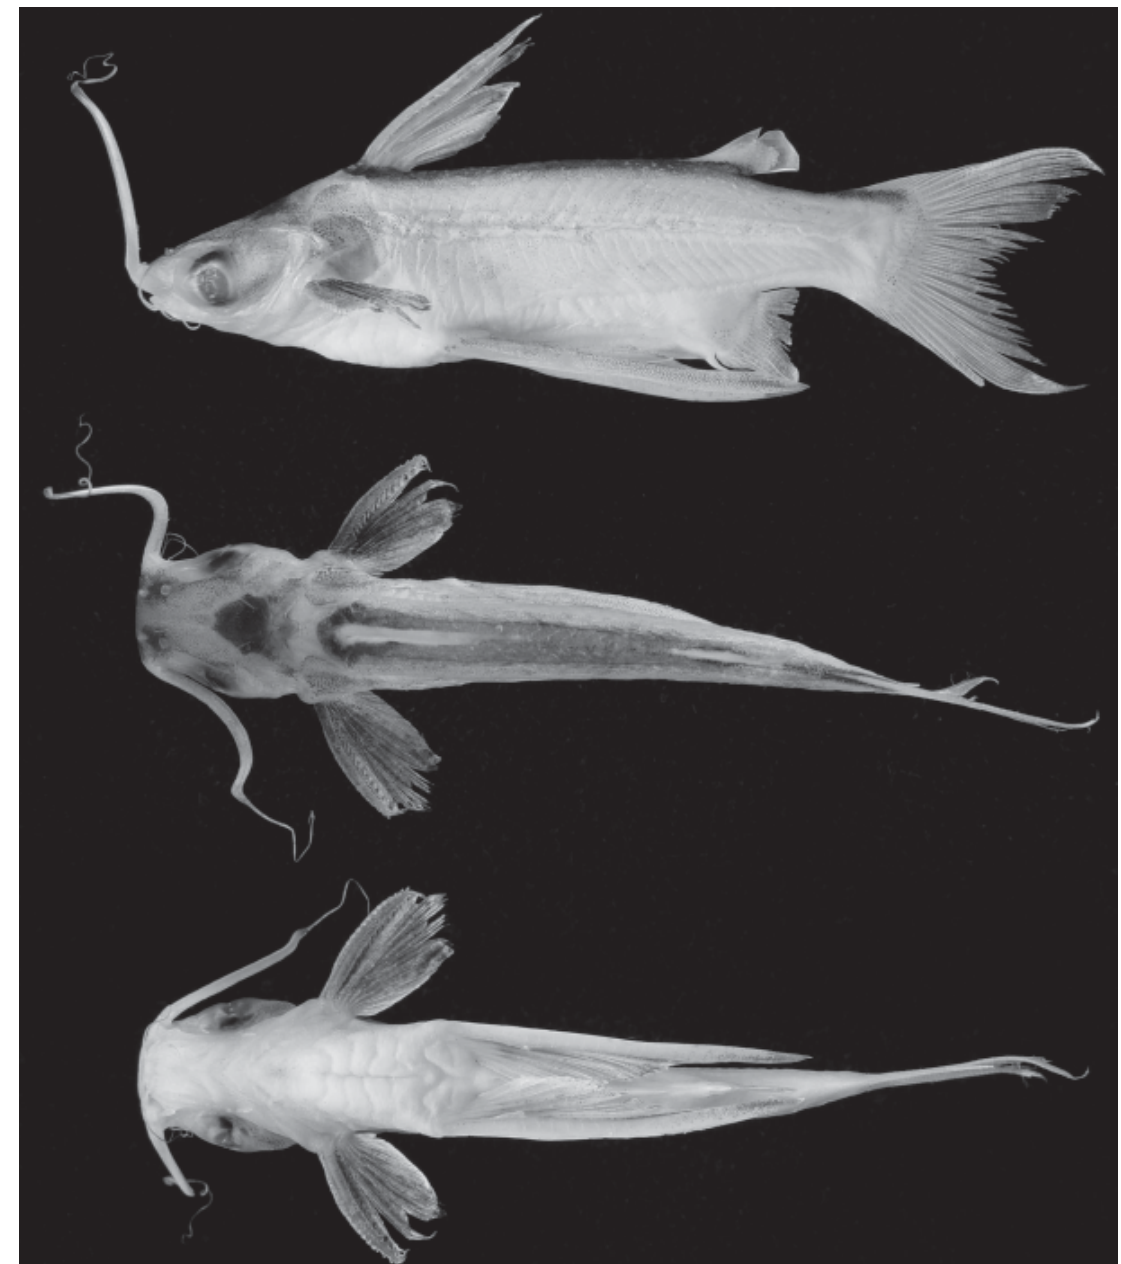
Fig. 1. Entomocorus melaphareus , holotype, MZUSP 76413, 58.6 mm SL.